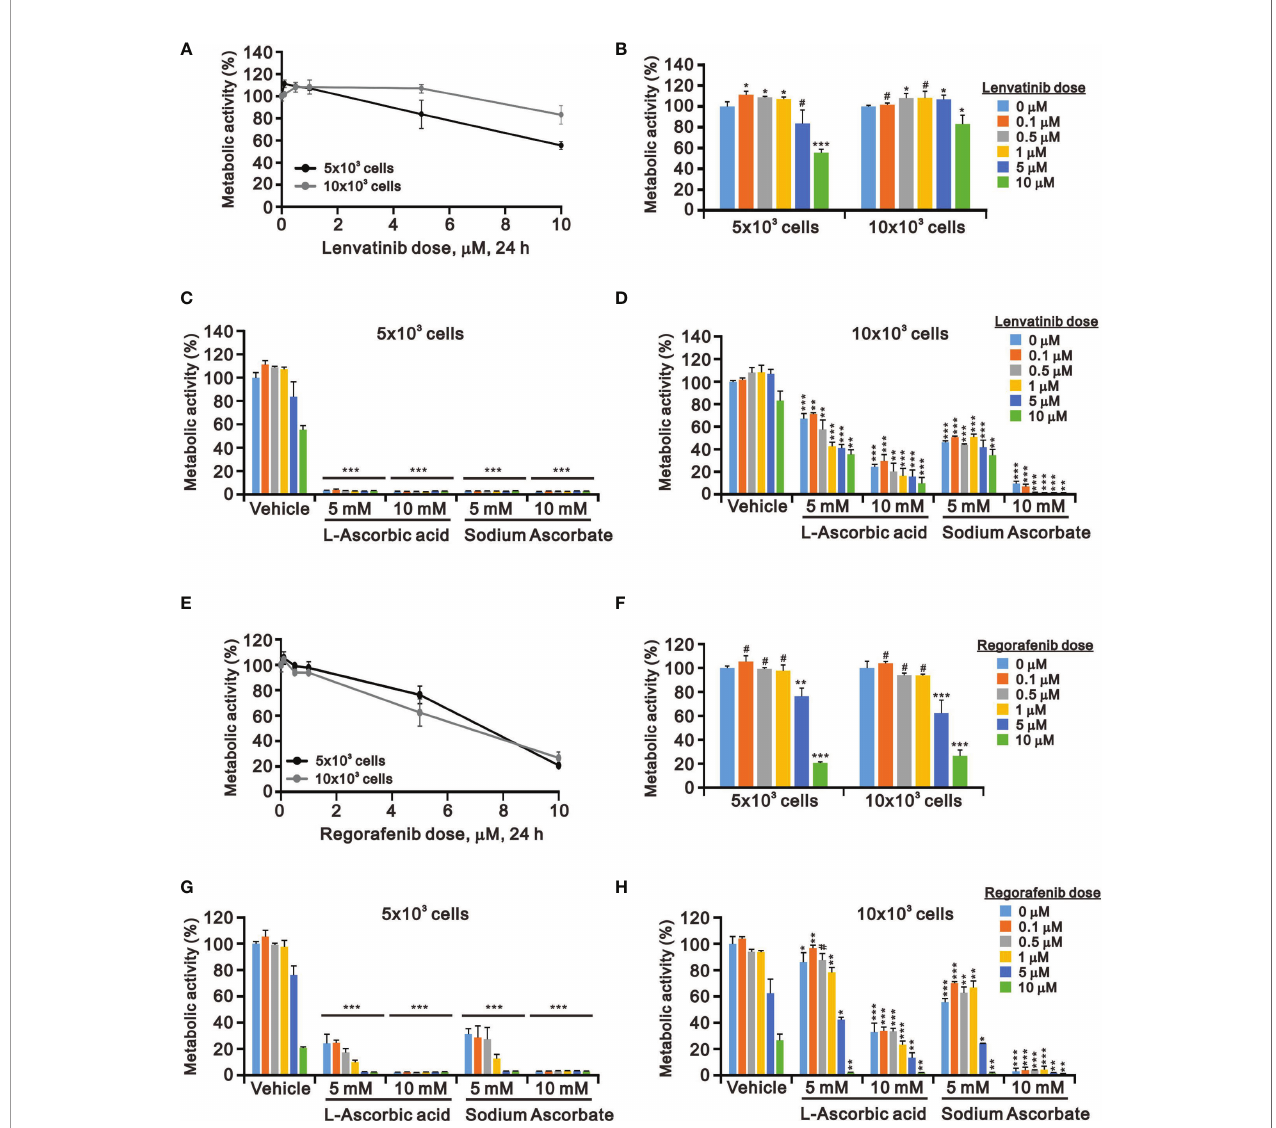
FIGURE 4 | Effects of ascorbate combined with TKIs on cell viability in HepG2 cells. HepG2 cells (5 × 10 3 and 1 × 10 4 ) were treated for 24 h with the indicated concentrations of (A – D) lenvatinib or (E – H) regorafenib in the absence or presence of 5- or 10-mM L -AA or sodium ascorbate. Cell metabolic activity was measured using the MTT assay. We show one representative result. Bars depict the mean ± SD of three independent experiments. # p > 0.05, * p < 0.05, ** p < 0.01, and *** p < 0.001 compared with the vehicle (Student ’ s